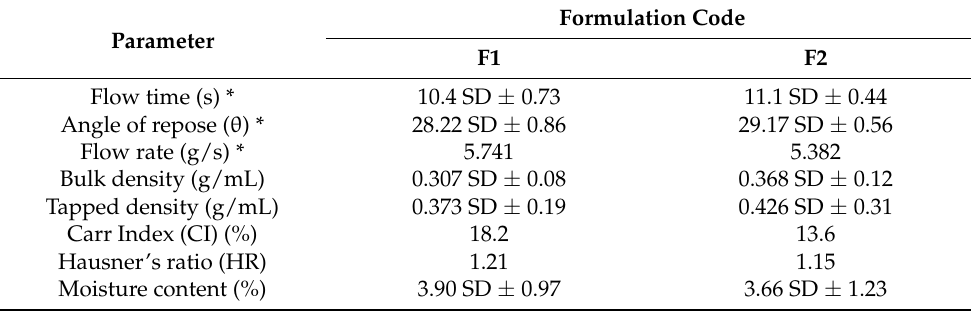
Table 6. Precompression parameters for the direct compression blend.